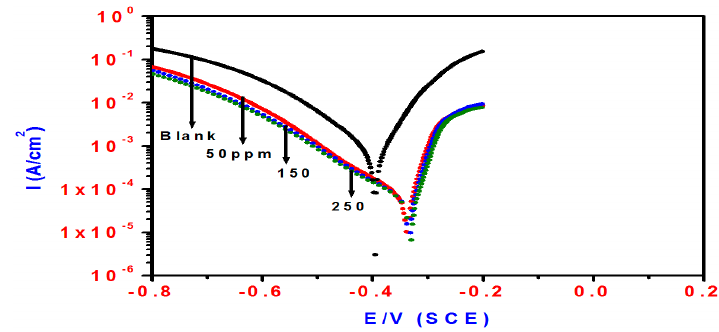
Figure 3. The effect of T3AMPy concentrations on the polarization curves of steel in acidic chloride solutions.